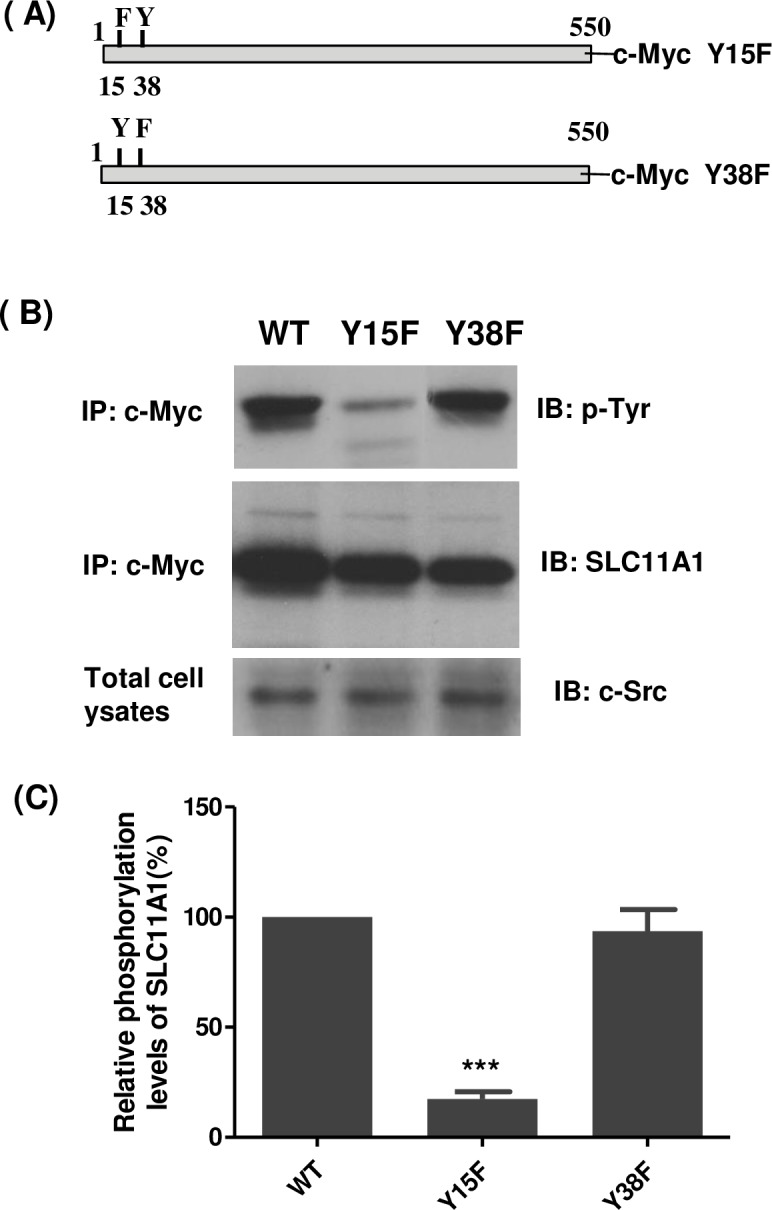
Identification of the tyrosine phosphorylation site of SLC11A1 by c-Src.(A) Site-directed mutagenesis was used to make the Tyr to Phe substitution at position 15 or 38 of SLC11A1. (B) U937 cells stably expressing c-Myc-tagged wild-type or mutated SLC11A1 (Y15F or Y38F) were transiently transfected with a pCB6-Src vector. 24 hours after transfection, cells were treated with PMA for 48 hrs. Cell lysates were prepared and immunoprecipitated with anti-c-Myc antibody (9E10). The tyrosine phosphorylation of SLC11A1was analyzed by immunoblotting with antibody 4G10 to phosphotyrosine (top panel). The Western blots were stripped and re-probed with an antibody against SLC11A1 (middle panel). The expression of c-Src (bottom panel) was also analyzed using anti-Src antibody. (C) The level of SLC11A1 phosphorylation in transfected cells was quantified by densitometry analysis and normalized to the level of total SLC11A1 protein. The relative phosphorylation level of the WT SLC11A1 in U937 cells was set as 100%. Data represented as mean ± S.E.(n = 3). ***P <0.001, compared with WT SLC11A1.